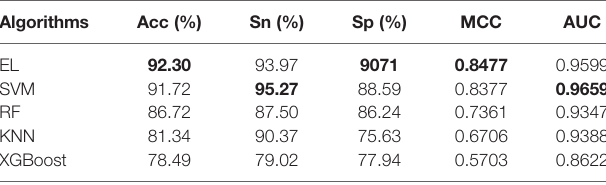
TABLE 7 | The prediction results of different classi fi ers for predicting pupylation sites. Algorithms